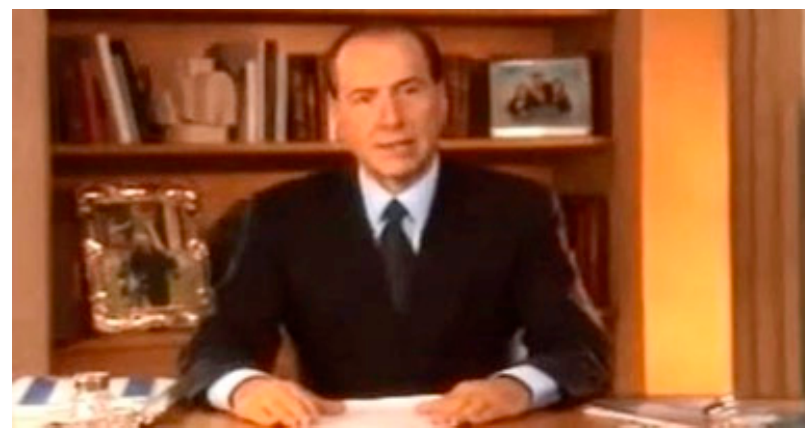
Figure 3. Frame from the announcement of Silvio Berlusconi’s entrance on the political scene and the Forza Italia party, 26 January 1994. (Available at: https://www.youtube.com/watch?v=B8-uIYqnk5A, last accessed: 21 August 2017).